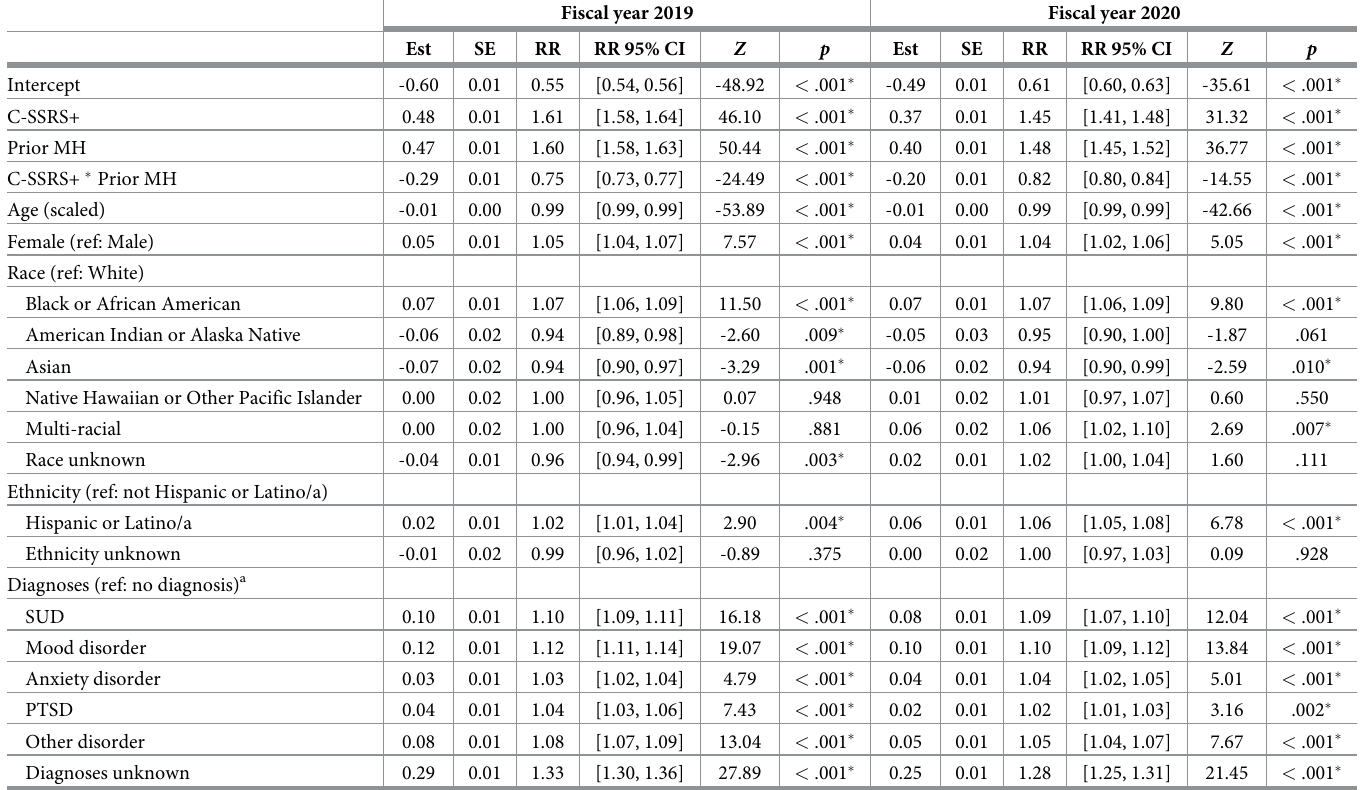
Table 3. Mental health engagement (2+ visits within 90 days of